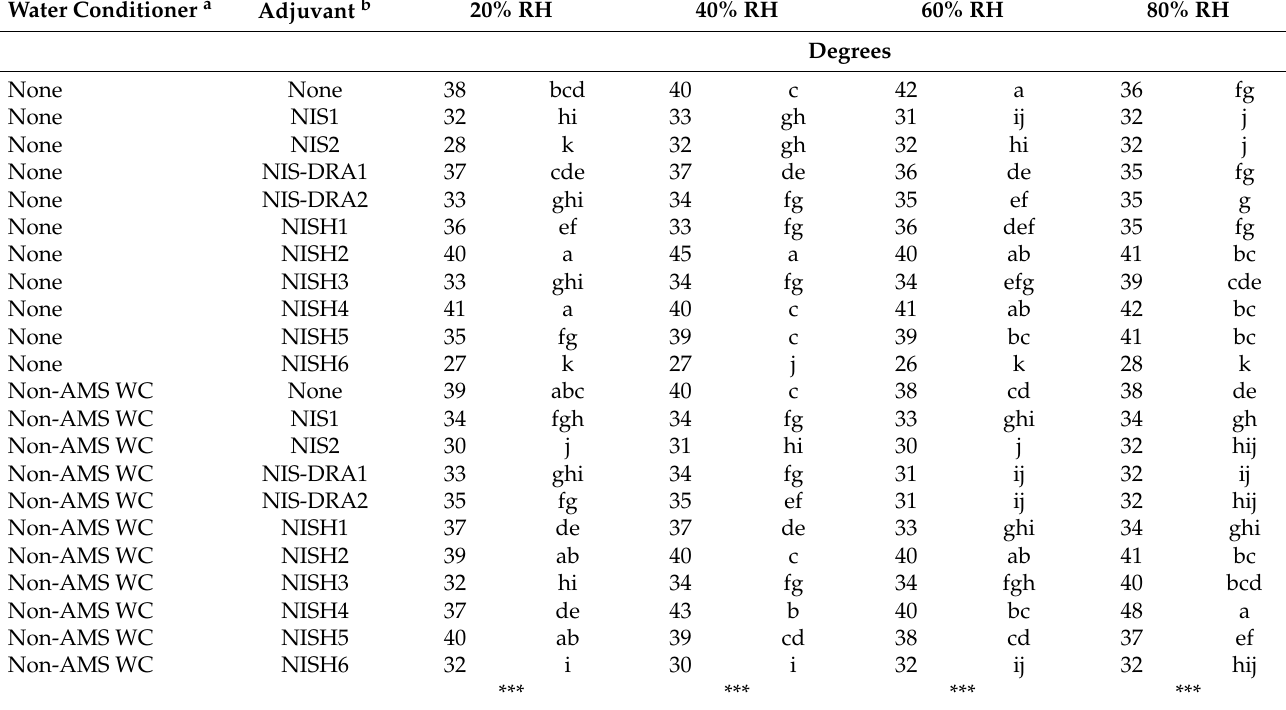
Table 5. Static contact angle for dicamba plus glyphosate solutions at 559 and 1541 g ae ha − 1 , respectively, with and without non-AMS water conditioner alone and tank mixed with 10 adjuvants at 25 ◦